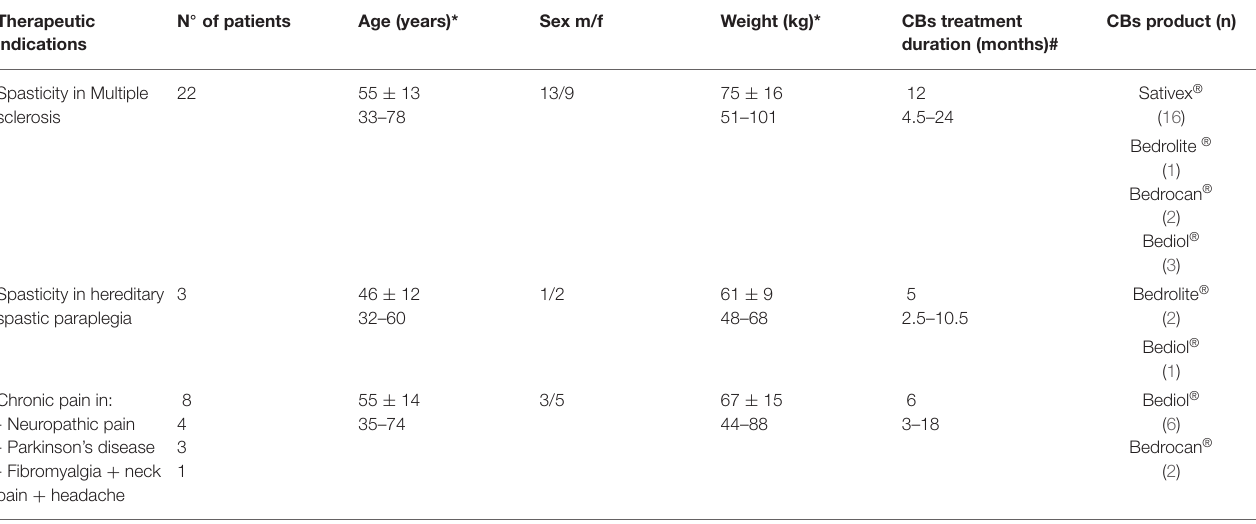
TABLE 1 | Patients’ characteristics associated with cannabinoid-based preparations grouped by type of disease. Therapeutic indications